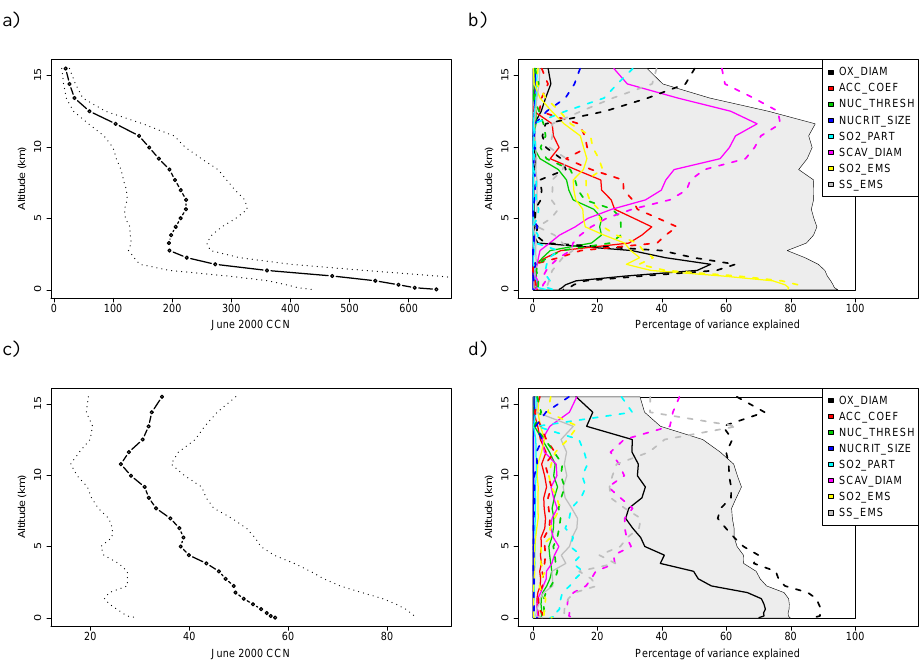
Fig. 10. Emulator estimated CCN concentration (solid line) and its 95% confidence interval due to uncertainty in the model parameters (dotted line) in (a) London and (c) the Pacific Ocean as estimated by the emulator at 26 model levels. The results from the 26 emulators are shown as circles but have been linearly interpolated to show the vertical profile. The variance contribution (%) or sensitivity of each parameter is shown in (b) for London and (d) for the Pacific Ocean. The solid lines show the main effect sensitivity and the dashed lines show the total effect sensitivity. The shaded background shows the total uncertainty explained by the main effects of each parameter; this is the maximum uncertainty that could be measured using one-at-a-time tests. Table 2. Model parameters and their effect on the variance of CCN concentration at the surface in a remote grid cell over the Pacific Ocean. Expected CCN = 57cm − 3